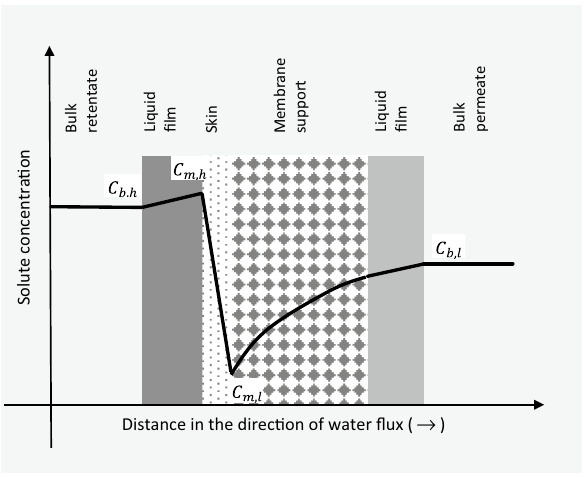
Figure 1. Schematic concentration profile depicted for OARO membranes 44